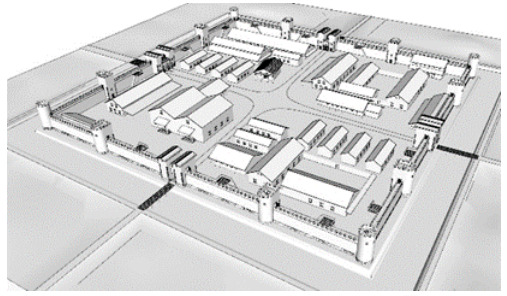
Figure 3a. 'White' model of the castellum